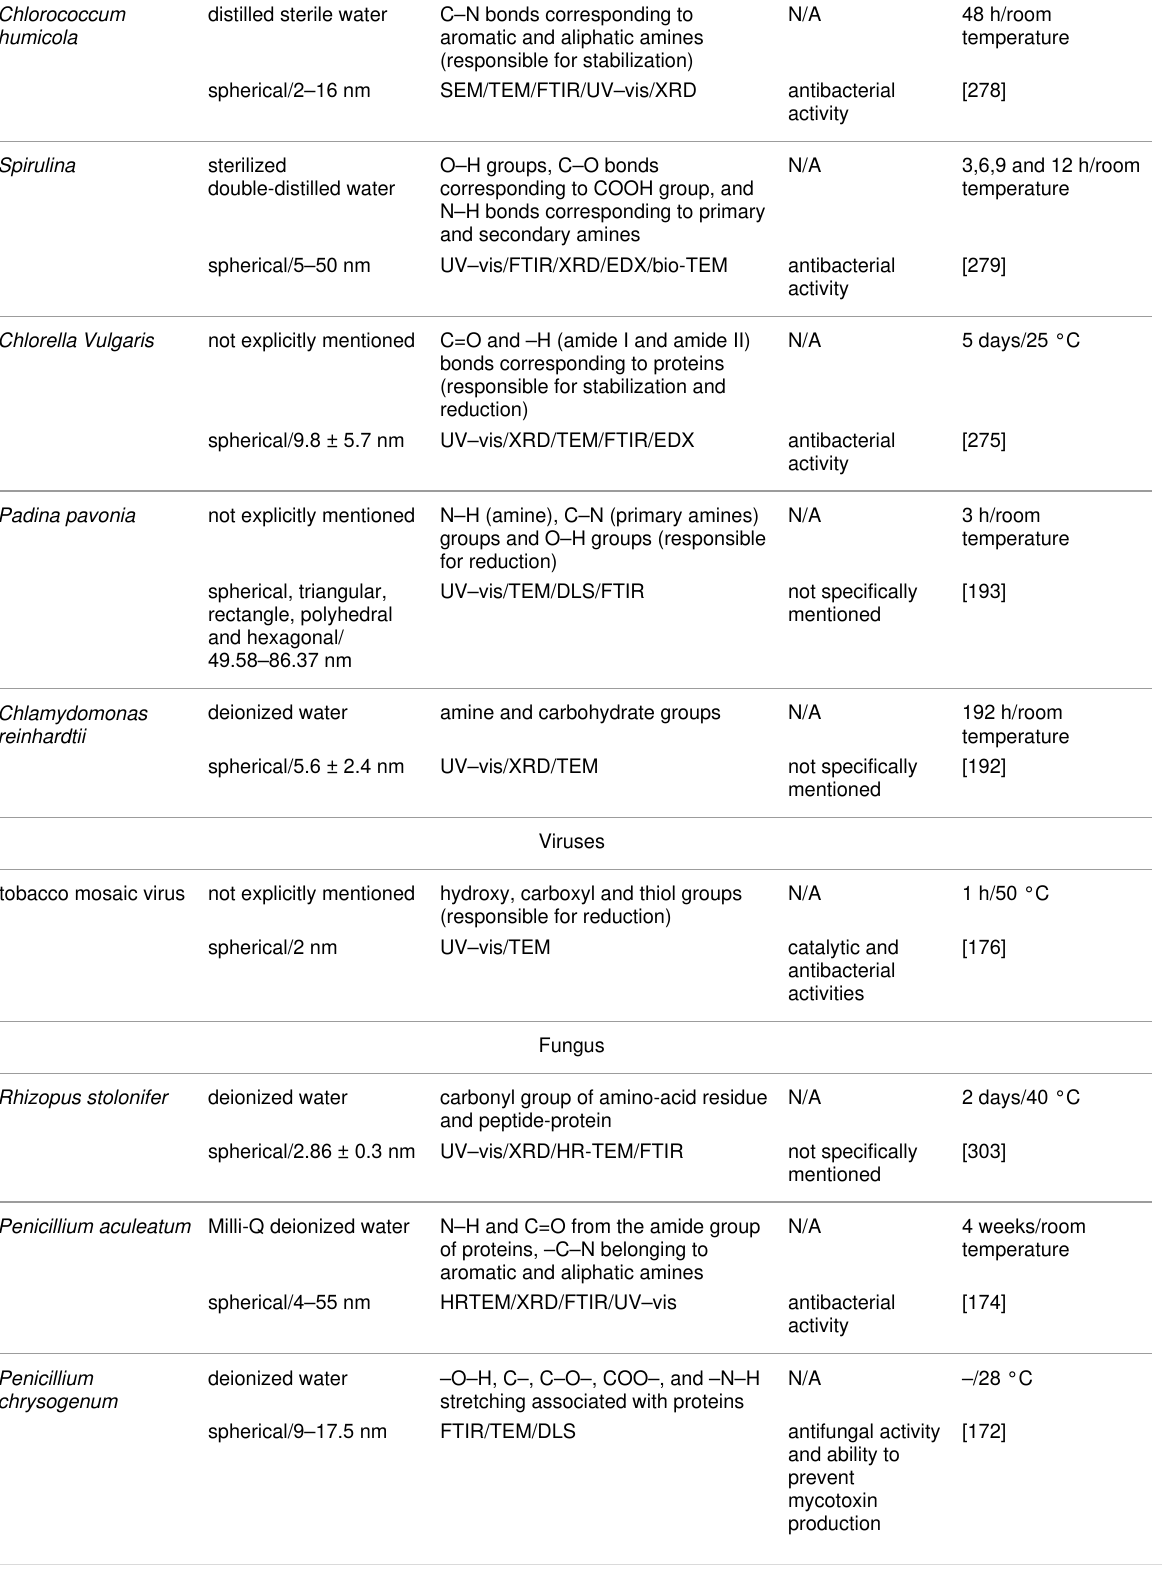
Table 2: A review of various green processes, reaction conditions, necessary functional groups, and characterization techniques used for the synthe- sis of silver nanostructures with different sizes and morphologies along with their application. (continued) Chlorococcum